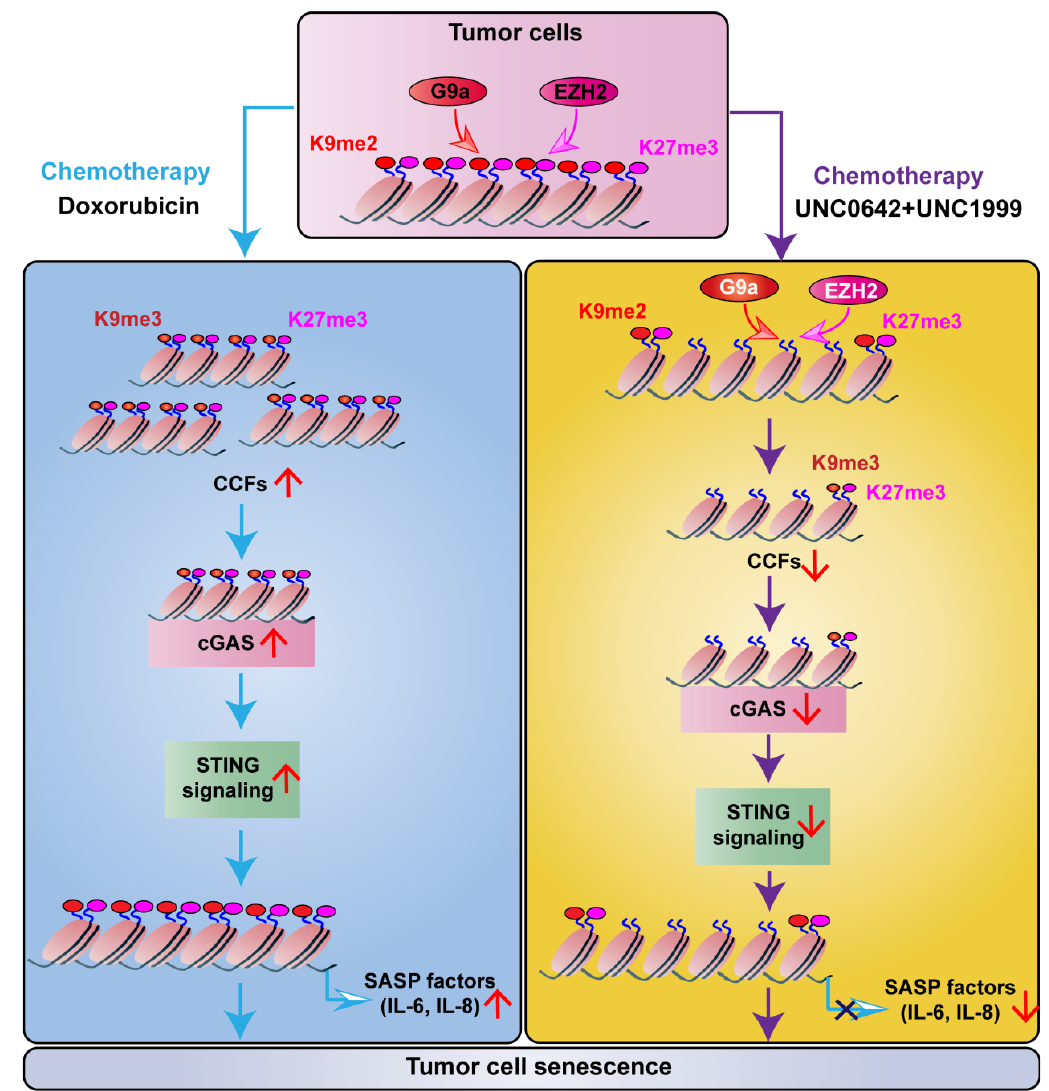
Figure 5. Work model. In tumor cells, doxorubicin induces cell senescence, as indicated by the increased formation of CCF. Thereby, CCF targets and activates the cGAS-STING-SASP, causing the secretion of IL-6 and IL-8. Meanwhile, a combination of UNC0642 and NC1999 inhibits the functions of G9a and EZH2, causing the decreasing levels of H3K9me3 and H3K27me3. Moreover, dual inhibition of H3K9me2 and H3K27me3 promotes tumor cell senescence without triggering SASP by decreasing the formation of CCF, which is dependent on the inhibition of cGAS-STING signaling.